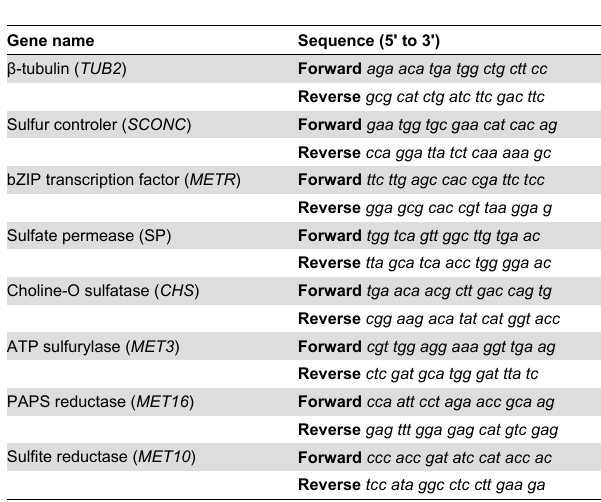
Table 2. List of primers used in this